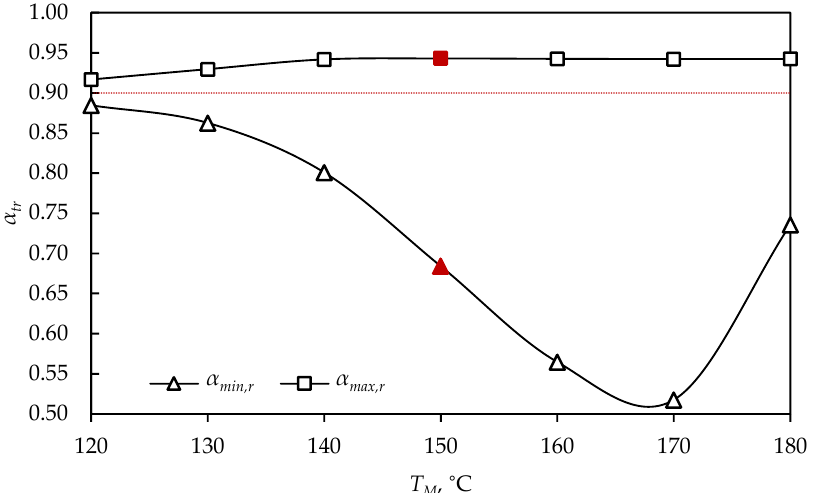
Figure 5. Vulcanization degree at t r , for a sphere ( D = 5 cm), obtained at different mold